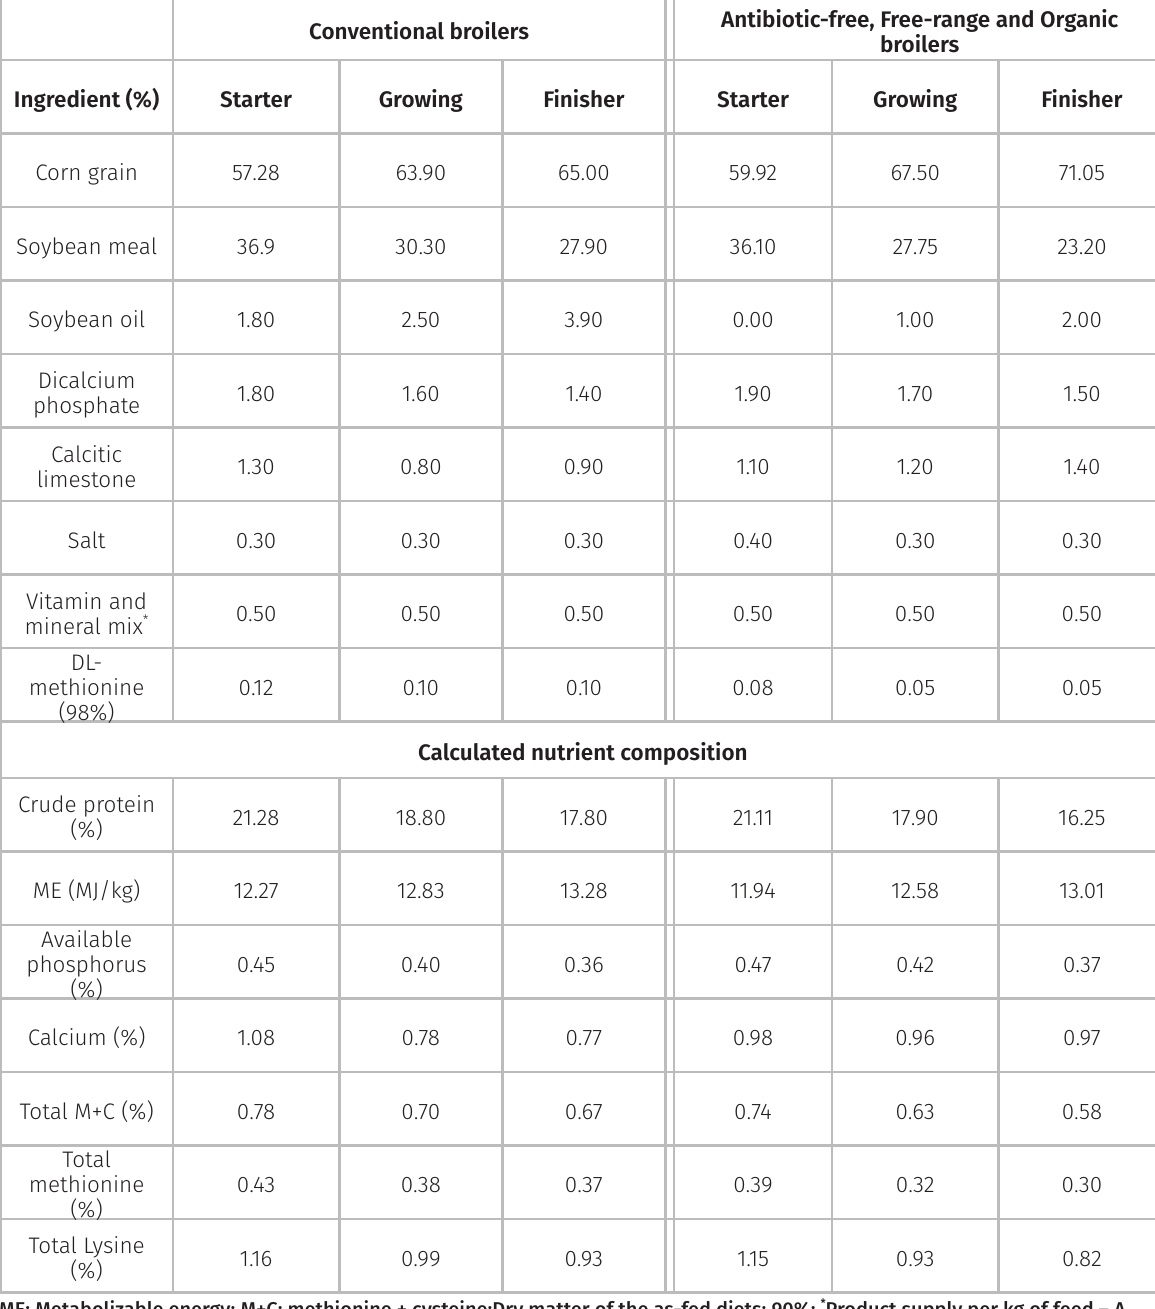
Table I. Composition and calculated nutrient content of diets (as-fed basis). Antibiotic-free, Free-range and Organic Conventional broilers broilers Ingredient (%) Starter Growing Finisher Starter Growing Finisher Corn grain 57.28 63.90 65.00 59.92 67.50 71.05 Soybean meal 36.9 30.30 27.90 36.10 27.75